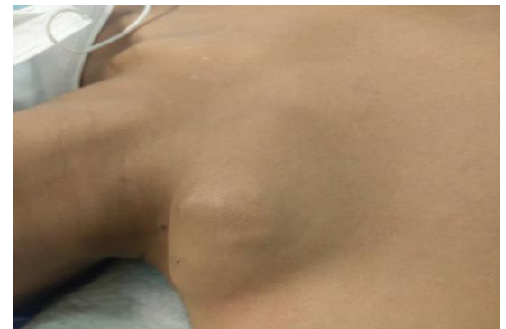
Figure 1: Chondroblastic osteosarcoma macroscopic